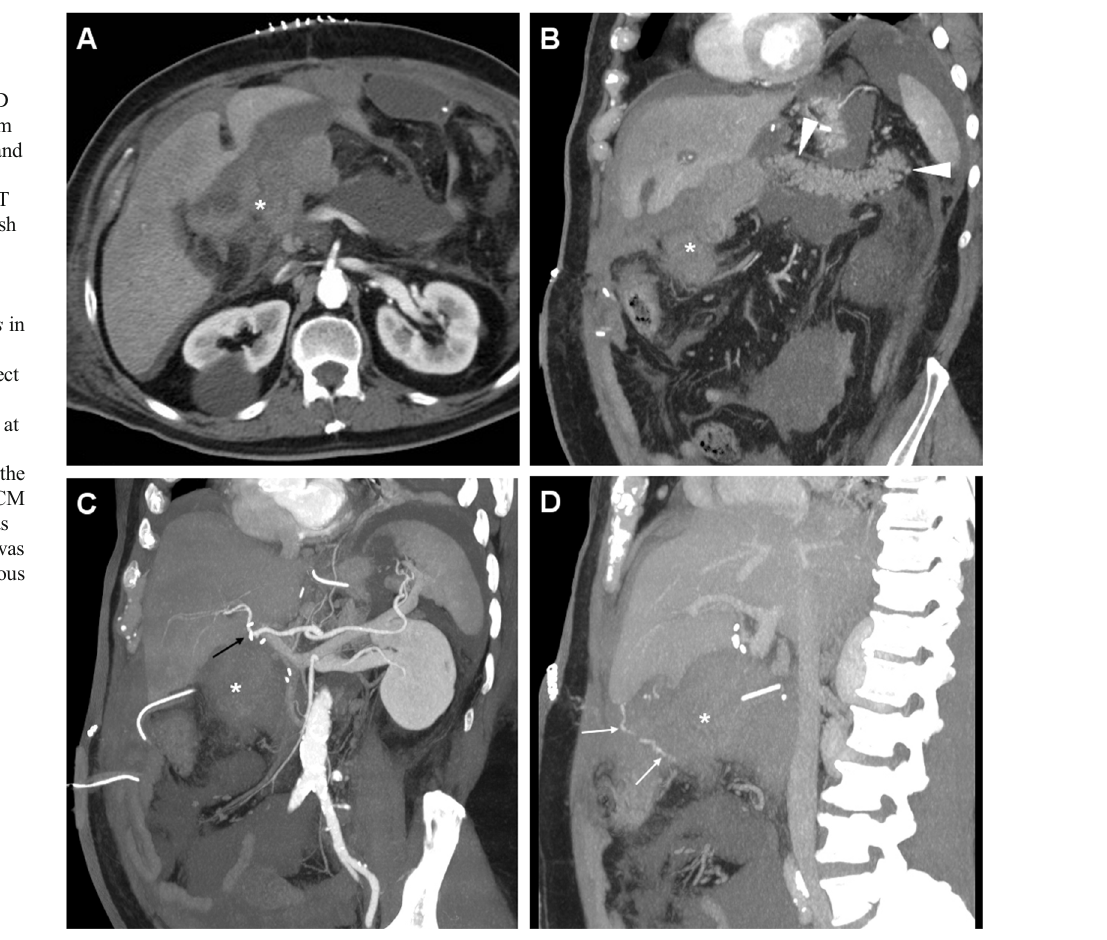
Fig. 11 Extraluminal haemorrhage in a 70-year-old man after PD for pT3N1 carcinoma of the Vaterian ampulla, who experienced acute abdominal pain on postoperative day 3: precontrast ( a ) showed hyperattenuating blood (*) extending ventrally from the surgical bed. Contrast-enhanced CT with thin-slab MIP reconstructions ( b , c ) showed